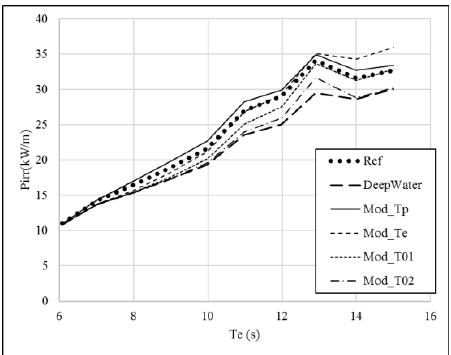
Figure 18. Modifications of the wave energy assessments using different characteristic periods ( h = 50 m).